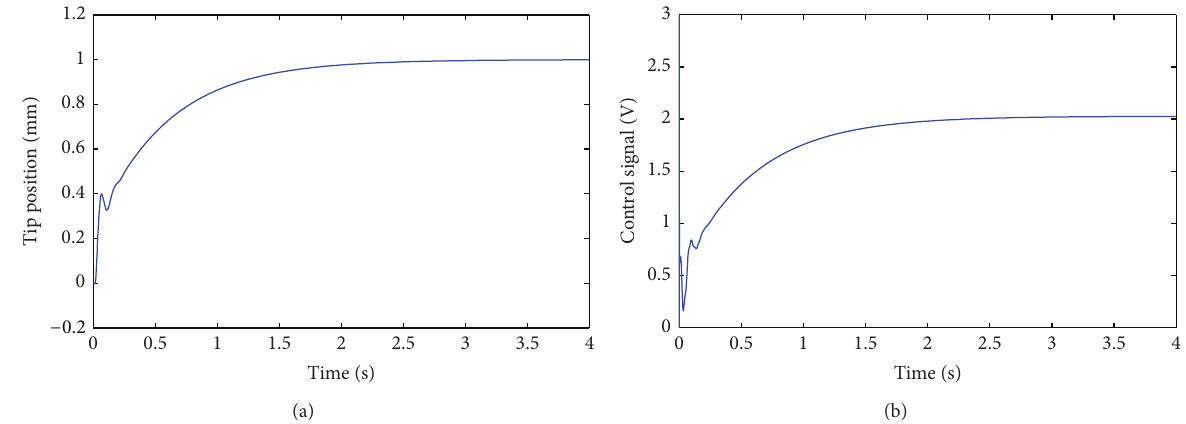
Figure 7: Step response of the closed-loop FE model using the fractional PID controller: (a) tip position, (b) control signal. 050